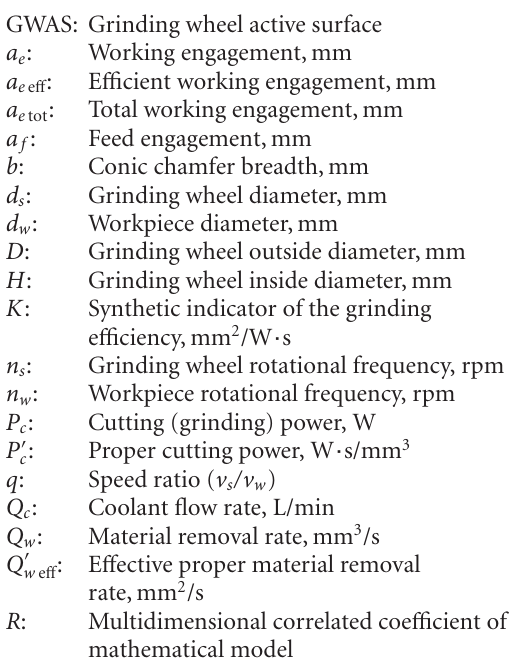
Multidimensional correlated coe ffi cient of mathematical